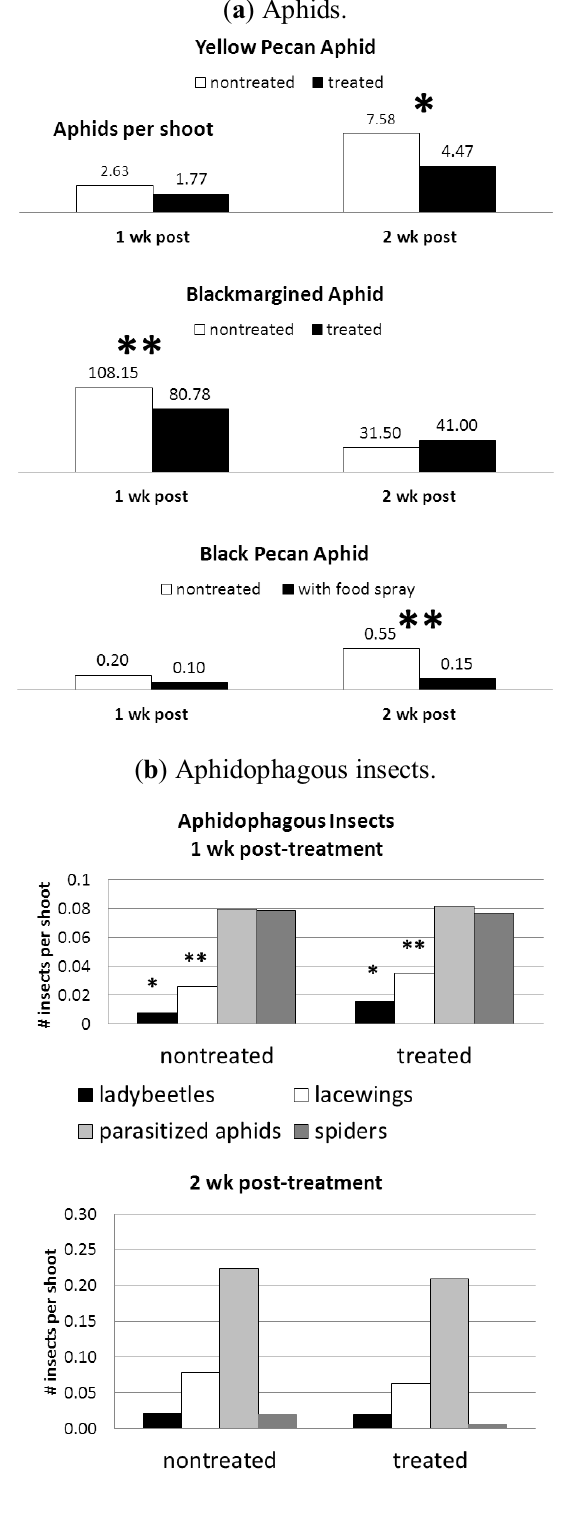
Figure 3. Comparison of aphid and aphidophagous insect abundance on pecan foliage in nontreated trees and trees treated with (cid:68)(cid:81)(cid:3)(cid:68)(cid:84)(cid:88)(cid:72)(cid:82)(cid:88)(cid:86)(cid:3)(cid:86)(cid:82)(cid:79)(cid:88)(cid:87)(cid:76)(cid:82)(cid:81)(cid:3)(cid:82)(cid:73)(cid:3)(cid:80)(cid:82)(cid:79)(cid:68)(cid:86)(cid:86)(cid:72)(cid:86)(cid:3)(cid:68)(cid:81)(cid:71)(cid:3)(cid:69)(cid:68)(cid:78)(cid:72)(cid:85)(cid:182)(cid:86)(cid:3)(cid:92)(cid:72)(cid:68)(cid:86)(cid:87) , on sampling dates of 1 and 2 w after treatment. Asterisks above and between the means in Figure 3a or over the bar in Figure 3b indicate that the means are significantly different between the treatments (one-way ANOVA, LSD test, * indicates p < 0.05, ** indicates p <